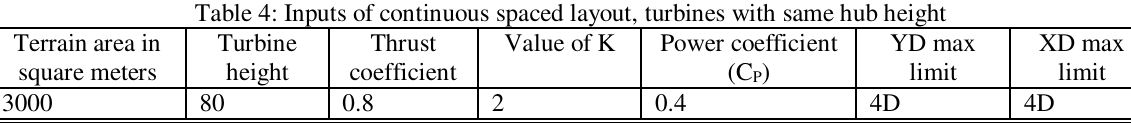
Table 5 : Turbine power and wind input of grid based